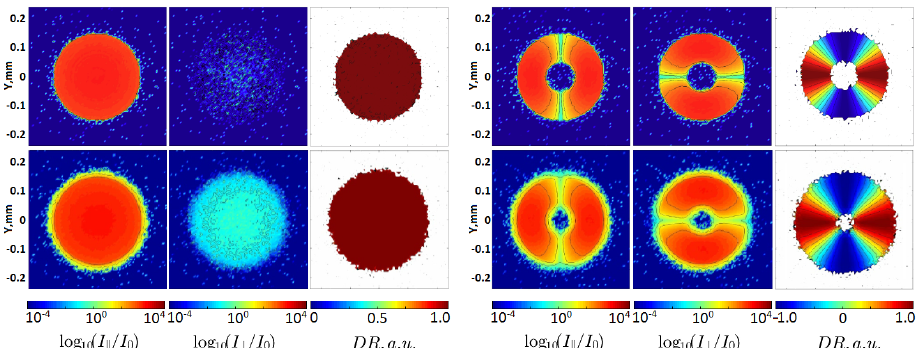
Figure 4. The results of MC simulation of co- I (cid:107) and cross- I ⊥ polarized components, and DR for a Gaussian ( left , supplementary video S1) and CVB ( right , supplementary video S2) with l = + 1, σ = − 1, transmitted through a turbid medium, with two sets of optical properties: g = 0.0, µ s = 1–30 mm − 1 , g = 0.9, µ s = 10–300 mm − 1 , in both cases thickness is 100 µ m.